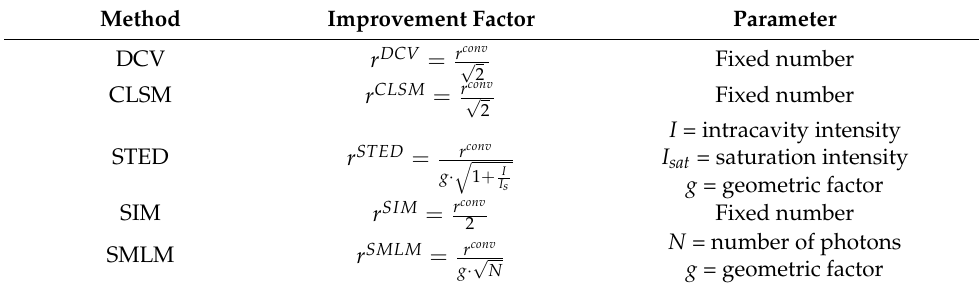
Table 5. Resolution improvement for confocal and super-resolution techniques. Method Improvement Factor Parameter DCV Fixed number